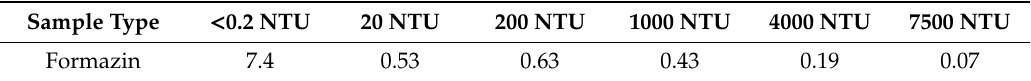
Table 4. Relative error rates of Formazin samples taken by the Hach.